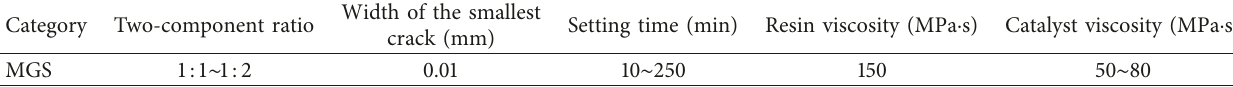
Table 4: Main technical parameters of construction chemical grouting.